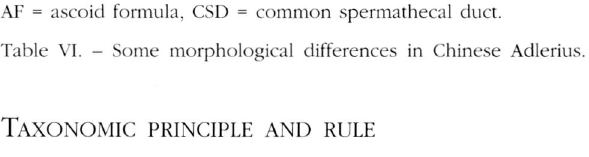
TAXONOMIC PRINCIPLE AND